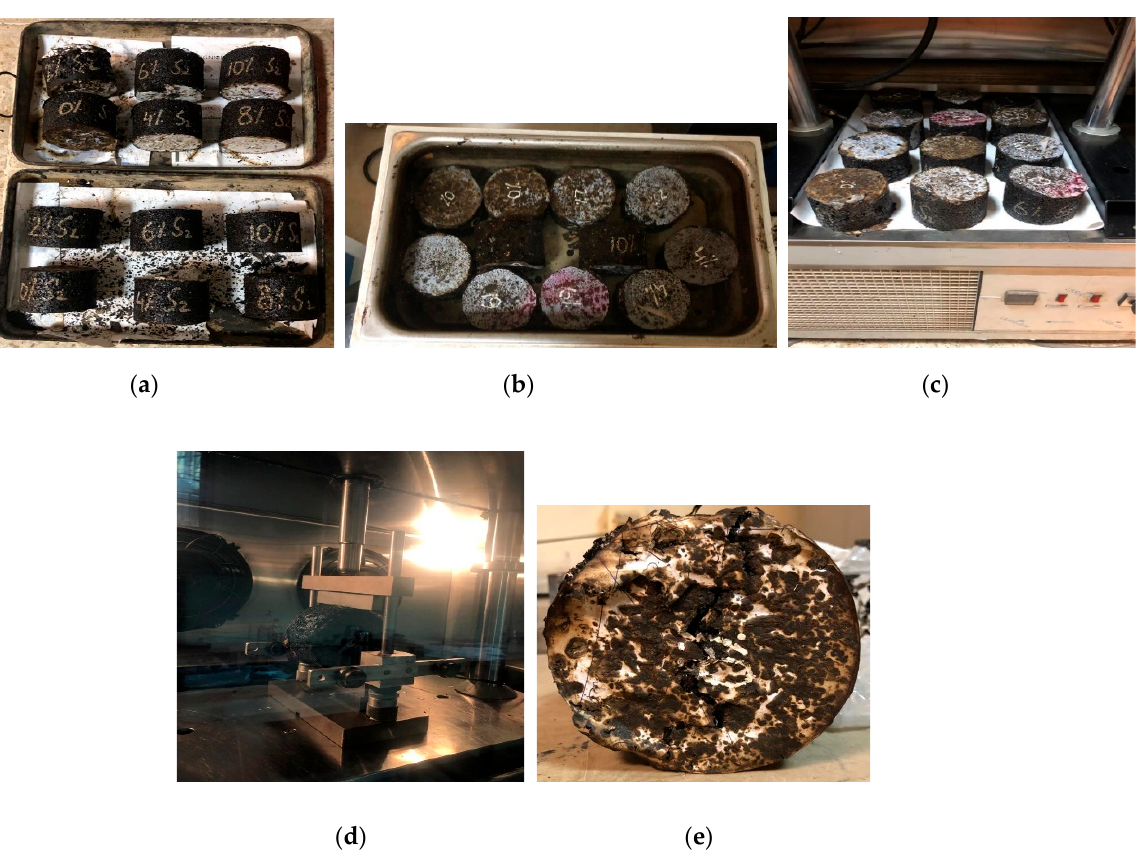
Figure 11. Moisture susceptibility testing: ( a ) Unconditioned samples ‘s-1’ and conditioned samples ‘s-2’; ( b ) Conditioning of samples in water bath for 24 h at 60 °C; ( c ) Unconditioned and conditioned samples kept at 25 °C for 4 h in a temperature-controlled chamber prior to testing; ( d ) Samples tested in UTM where the load was applied at 50 mm/min; ( e ) Fractured sample.